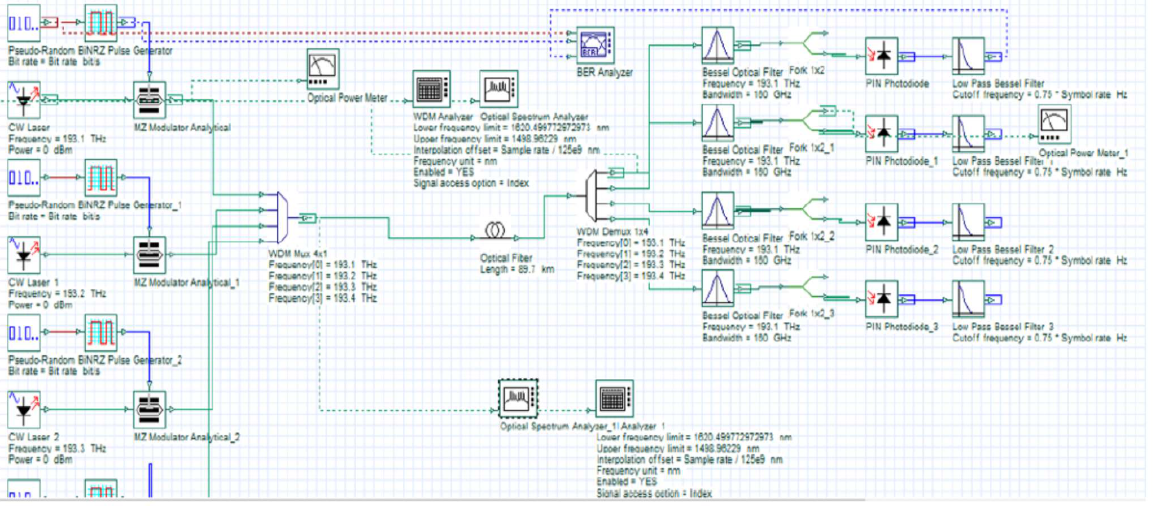
Figure 5. Model of 4 channel WDM system with review of measuring